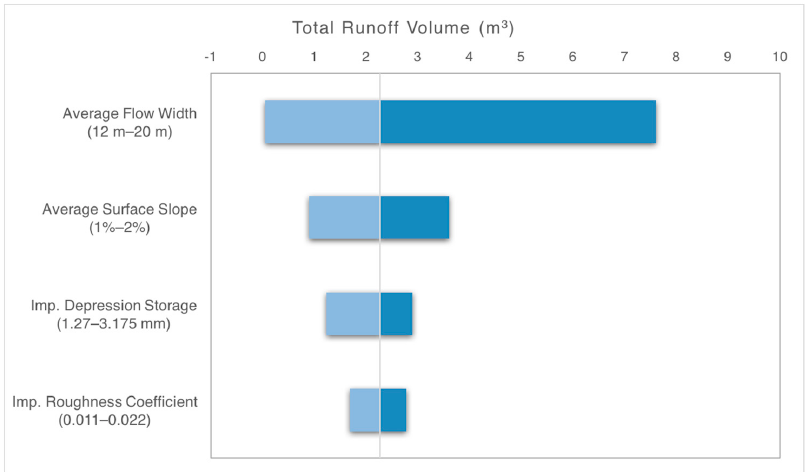
Figure 5. Sensitivity analysis tornado plot of model parameters and their effect on total runoff volume.